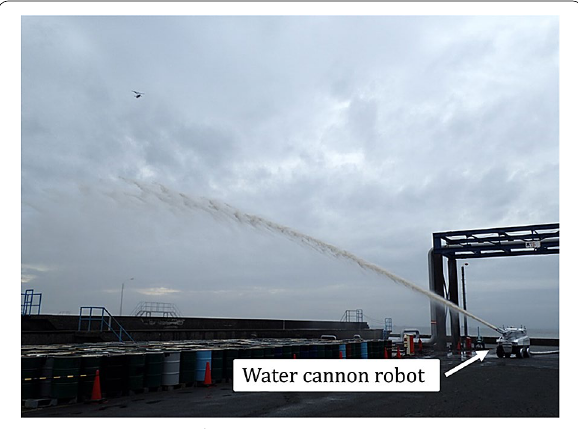
Fig. 2 Water cannon robot in